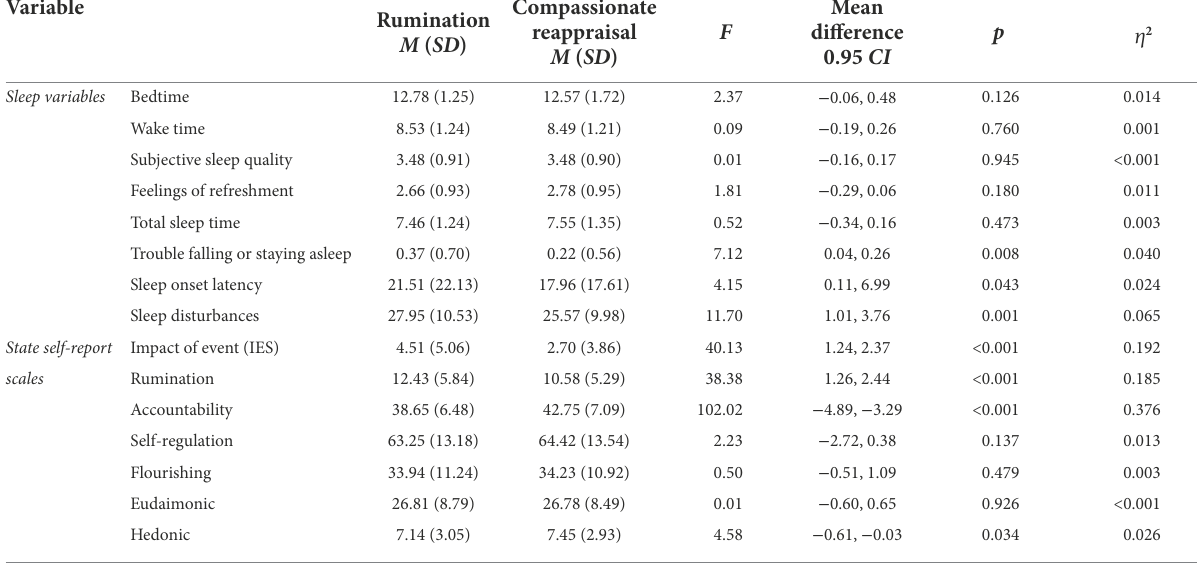
TABLE 3 Morning measure means, standard deviations, F values, 0.95 confidence intervals for condition mean differences, significance, and partial eta-squared effect sizes.